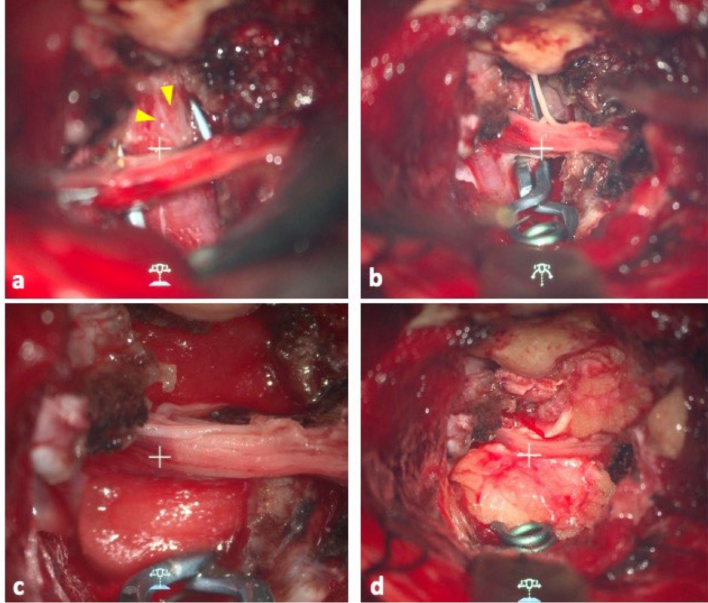
Figure 2. ( a ) Operative view of the aneurysm. Yellow arrowheads indicate the location of the bleb. ( b ) The clip blade was aligned parallel to the basilar artery, avoiding the fifth cranial nerve. ( c ) Operative view after DuraGen was applied to the remaining dome. ( d ) The same area was covered with the patient’s fascia to make the wrapping multilayered. The layers were fixed with fibrin